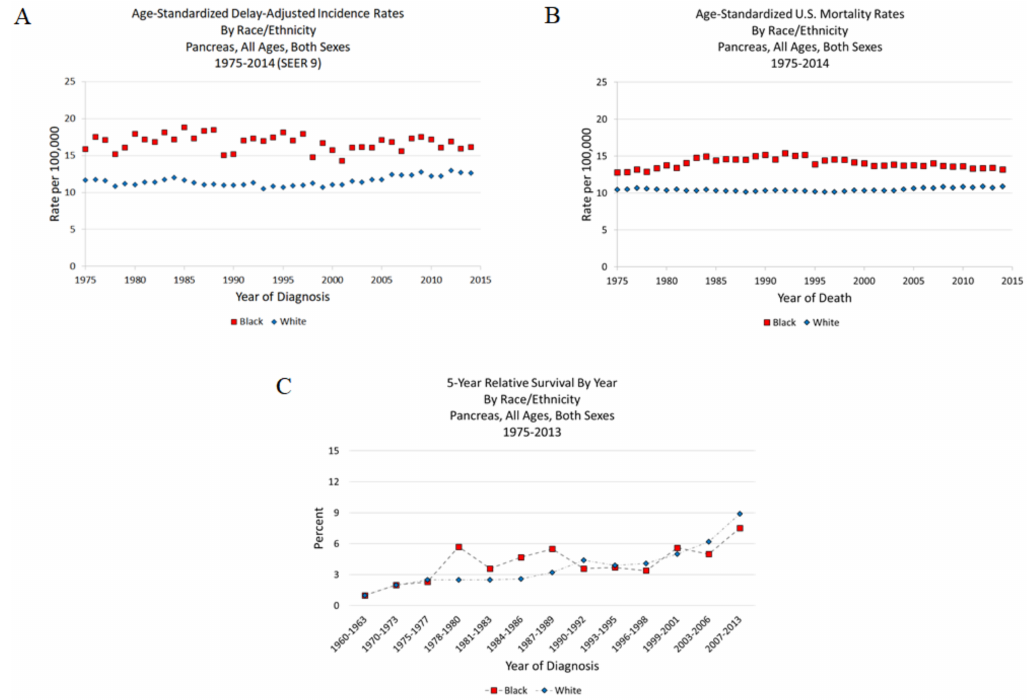
Figure 1. Pancreatic cancer statistics by race. ( A ) Age-Standardized Delay-Adjusted Incidence Rates. ( B ) Age-Standardized U.S. Mortality Rates. ( C ) 5-year Relative Survival by Year. All data for Blacks and Whites include Hispanic